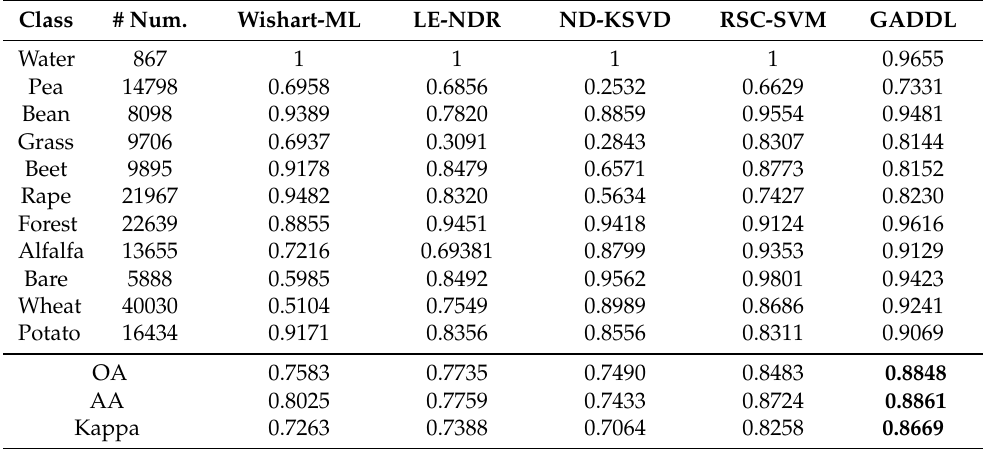
Table 1. The overall accuracy (OA), average accuracy (AA) and kappa coefficient values of different methods on Flevoland-1989 dataset. # Num. denotes the number of samples in each category. Class # Num. Wishart-ML LE-NDR ND-KSVD RSC-SVM GADDL